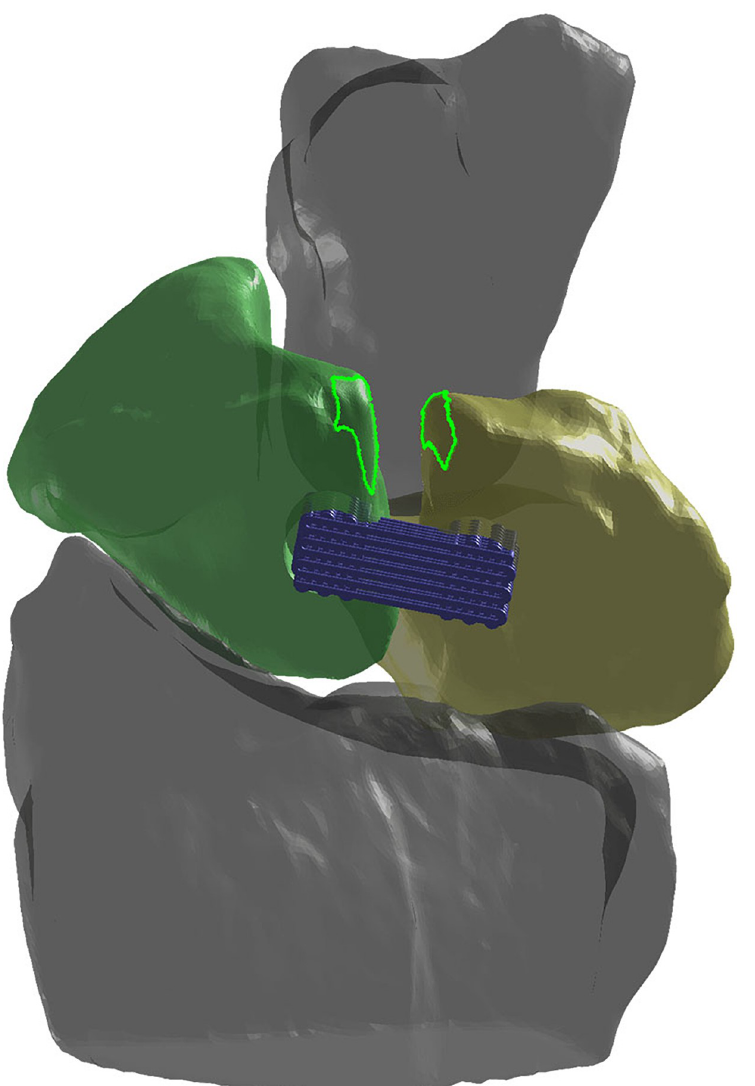
Fig 4. The 3D anatomical model created from computed tomography scan. The model consists of capitate (grey), scaphoid (green), lunate (yellow), and radius (grey) bones. Bone positions in dorsal view of anatomical model correspond to maximum wrist flexion. The attachment sites of the dorsal SLIL are depicted with green dotted lines on both scaphoid and lunate. The dorsal SLIL attachment sites are derived from MRI scan of intact native SLIL with the wrist at neutral position and projected onto the anatomical model created from computed tomography scan. The BLB scaffold is placed at a position proximal to the native attachment sites.